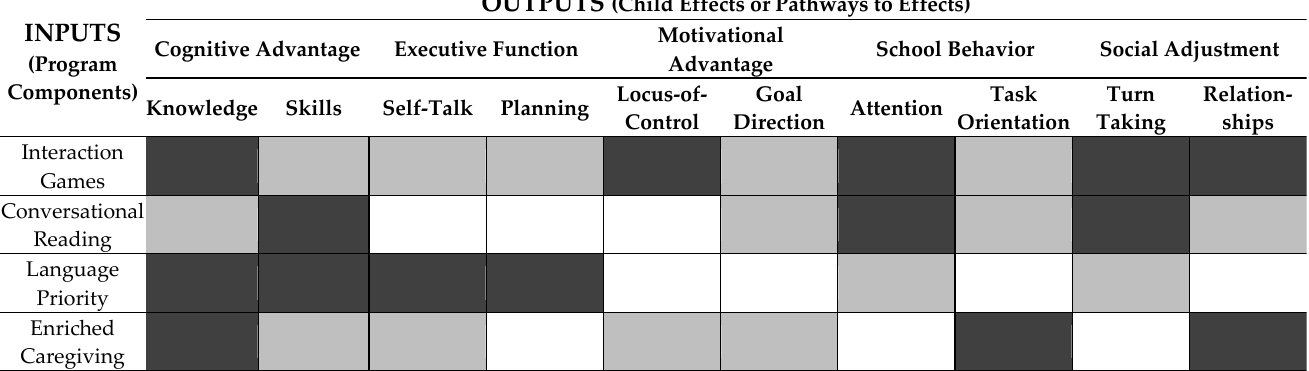
Table 1. Abecedarian input-output map.